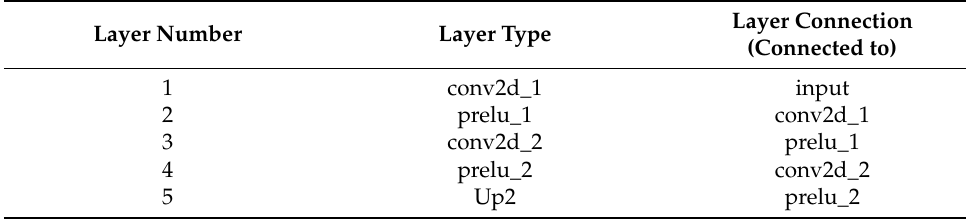
Table 4. Description of a decoder block of the generator network.